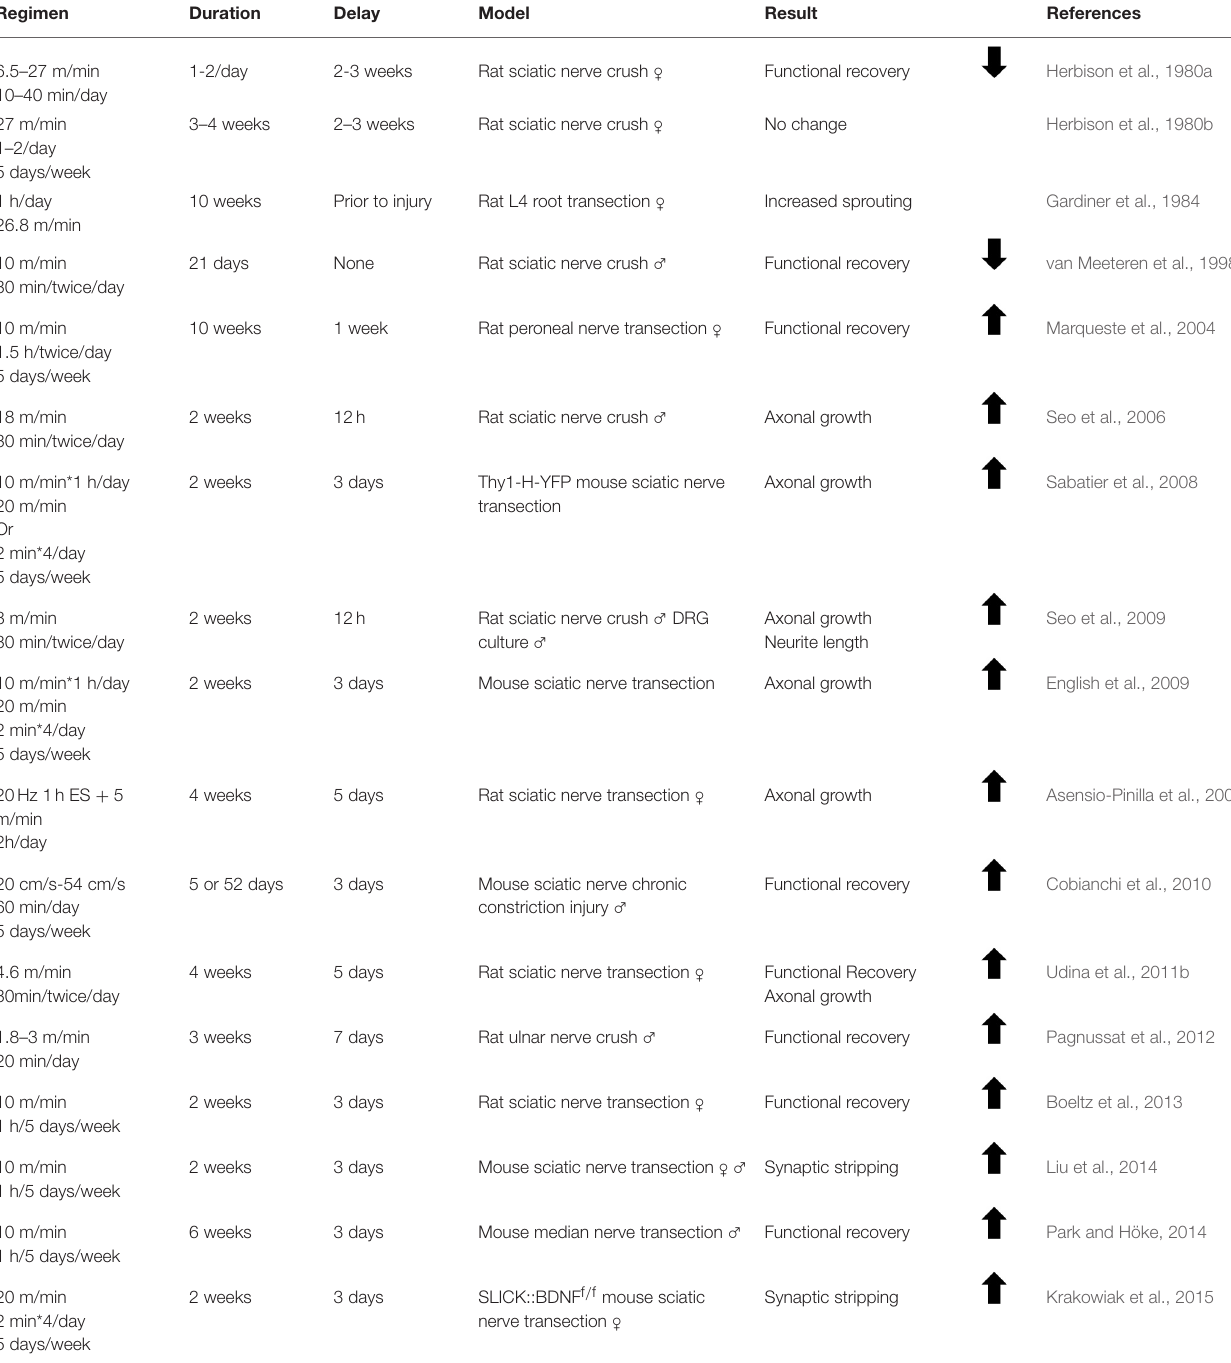
TABLE 2 | Effects of treadmill training on peripheral nerve